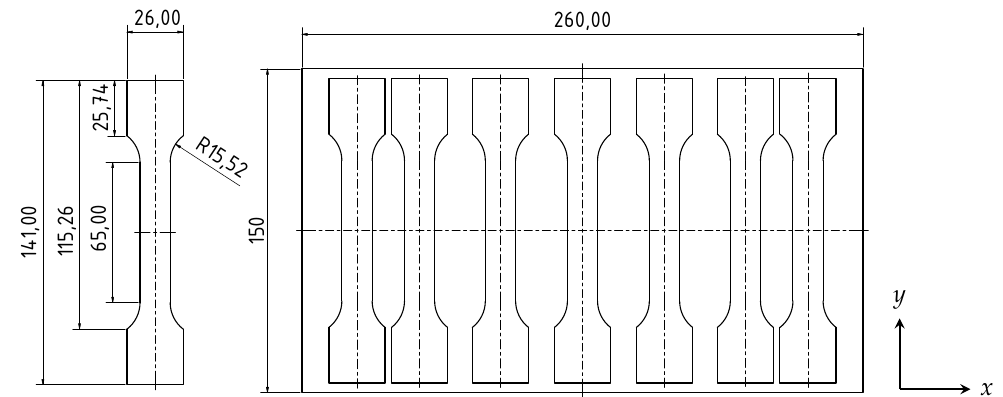
Figure 2. Geometry and location of extraction of the test specimens from the 4mm thick high pressure die casting (HPDC)